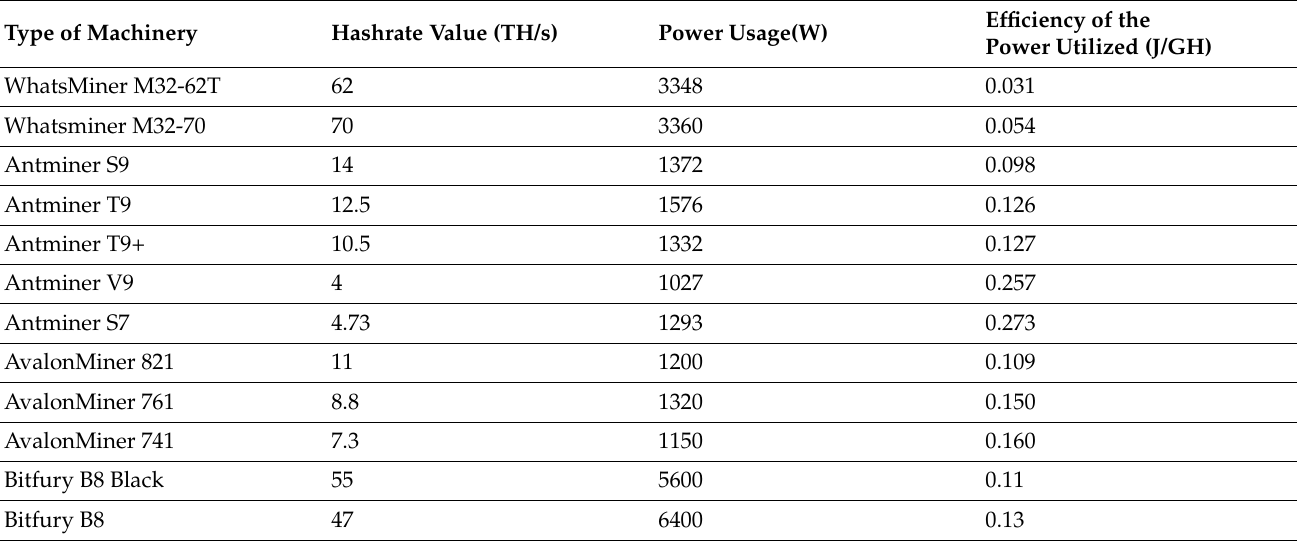
Table 5. Samples of Recent Bitcoin ASIC Mining Machinery [28,34,41] (Source: Bitmain, Bitfury, and